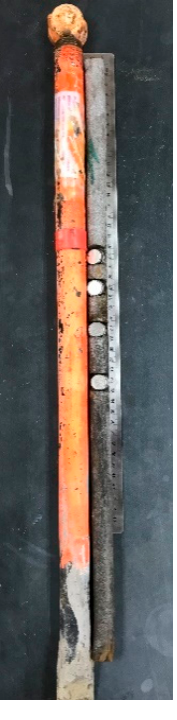
Figure 4. Vertical temperature sensing assembly with Thermocon iButtons temperature sensors removed from the pipe for visualization. The foam and Thermocon iButton assembly was inserted into the pipe, sealed and then driven into the riverbed to the red tape. Thermocon iButton sensors are 0, 3, 7 and 12 cm bellow the riverbed.